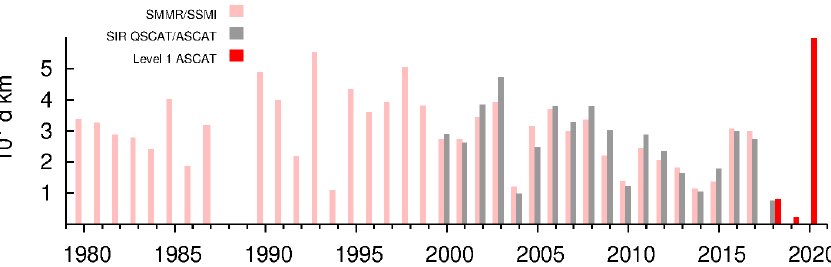
Figure 4. Melt index time series based on brightness temperatures from SMMR and SSMI, SIR QuikSCAT and ASCAT data, and Level 1 ASCAT